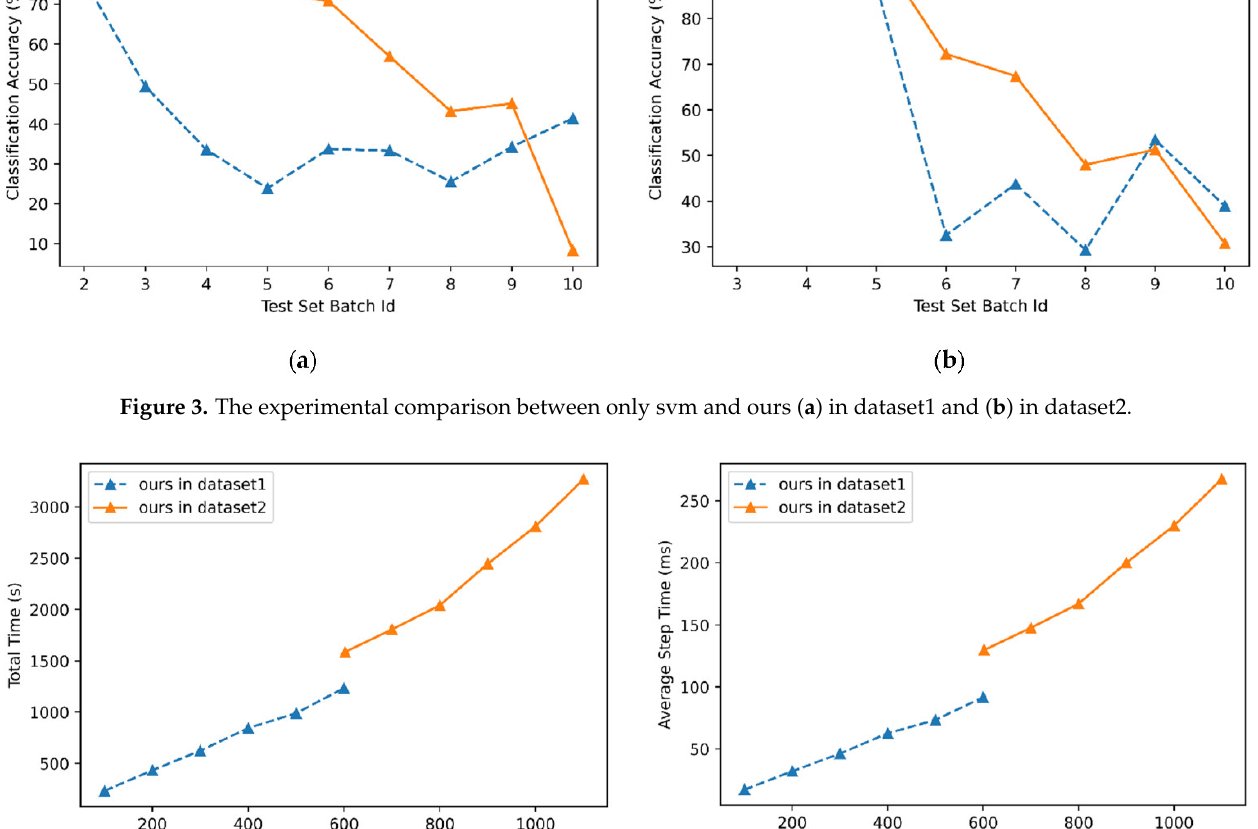
Table 8. Experimental comparison for dataset2.